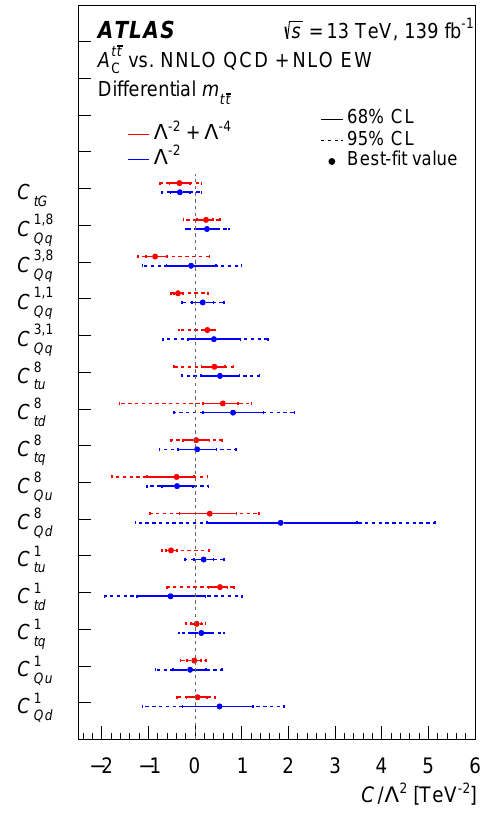
Figure 24. 68% and 95% individual limits on Wilson coefficients in the SMEFT framework from the differential A t ¯ t asymmetry as a function of m t ¯ t [60]. Only one coefficient is varied at a time while the C other are kept to